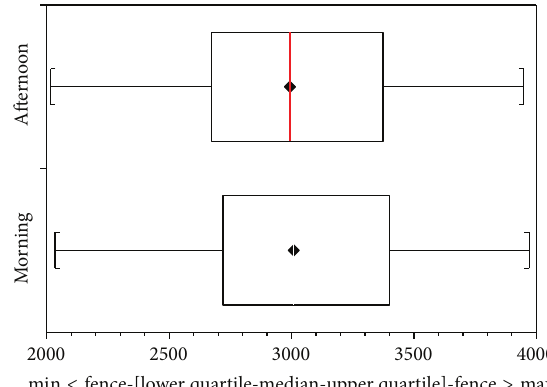
Figure 2: Interquartile variations in volume in the morning and the afternoon after using elastic stockings during the day (Assessment